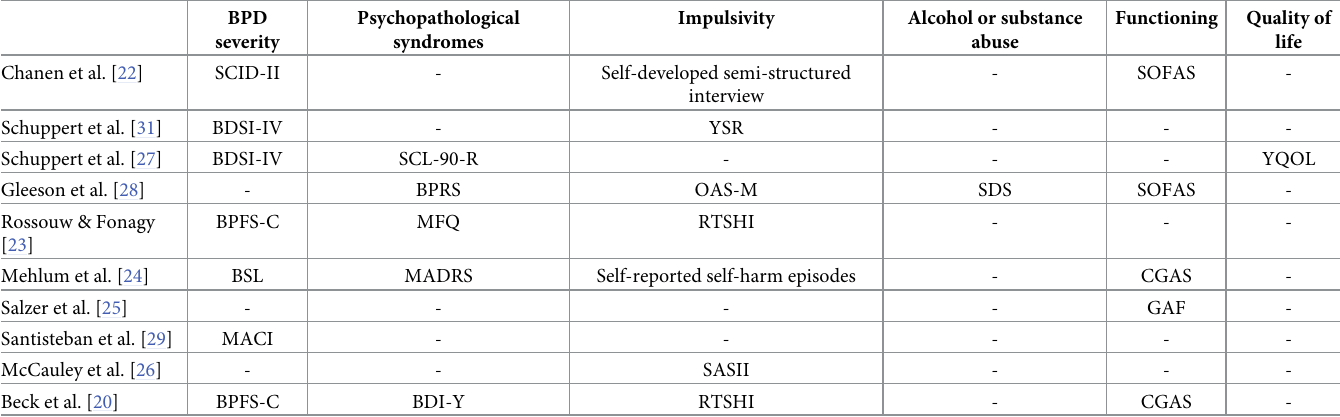
Table 3. Measures used within the included